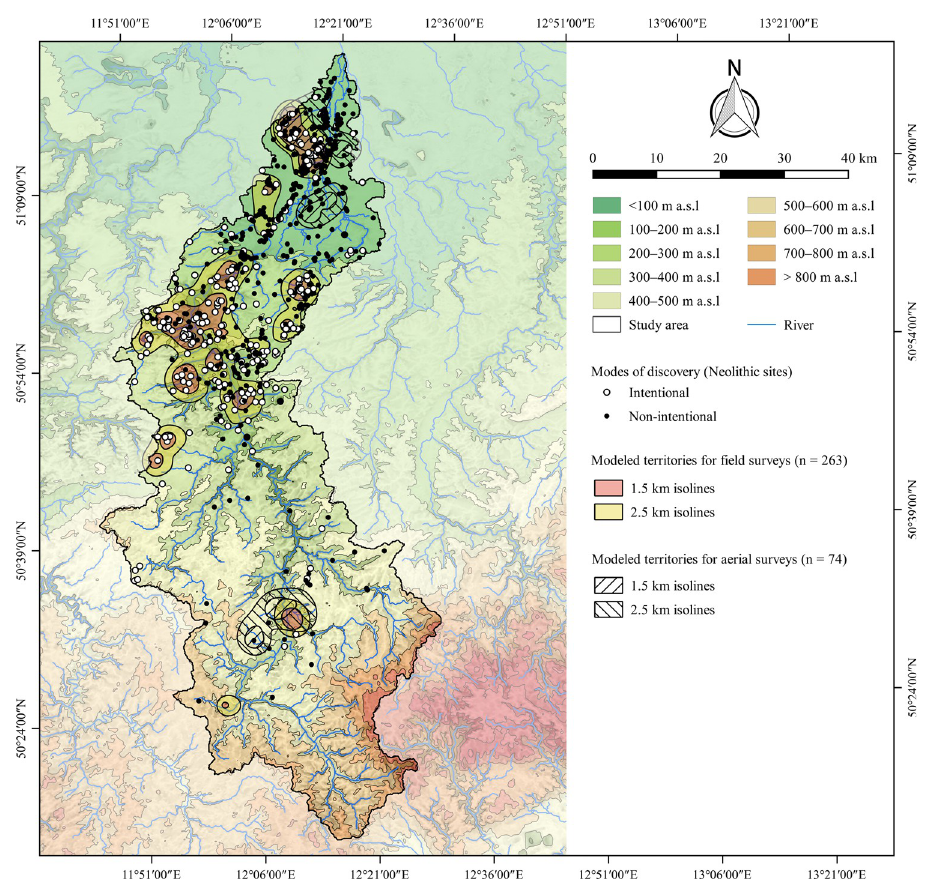
Fig 5. Distribution of Neolithic sites with respect to their modes of discovery against the background of areas investigated by field surveys and aerial photography. Rivers were plotted according to the European Catchments and Rivers network system [60]. The topography is based on the SRTM 90 m Digital Elevation Database version 4.1 [61– 63]. Topography and rivers have been modified according to older topographic maps (S2 Table). See Fig 2 for a location of the urban areas mentioned in the